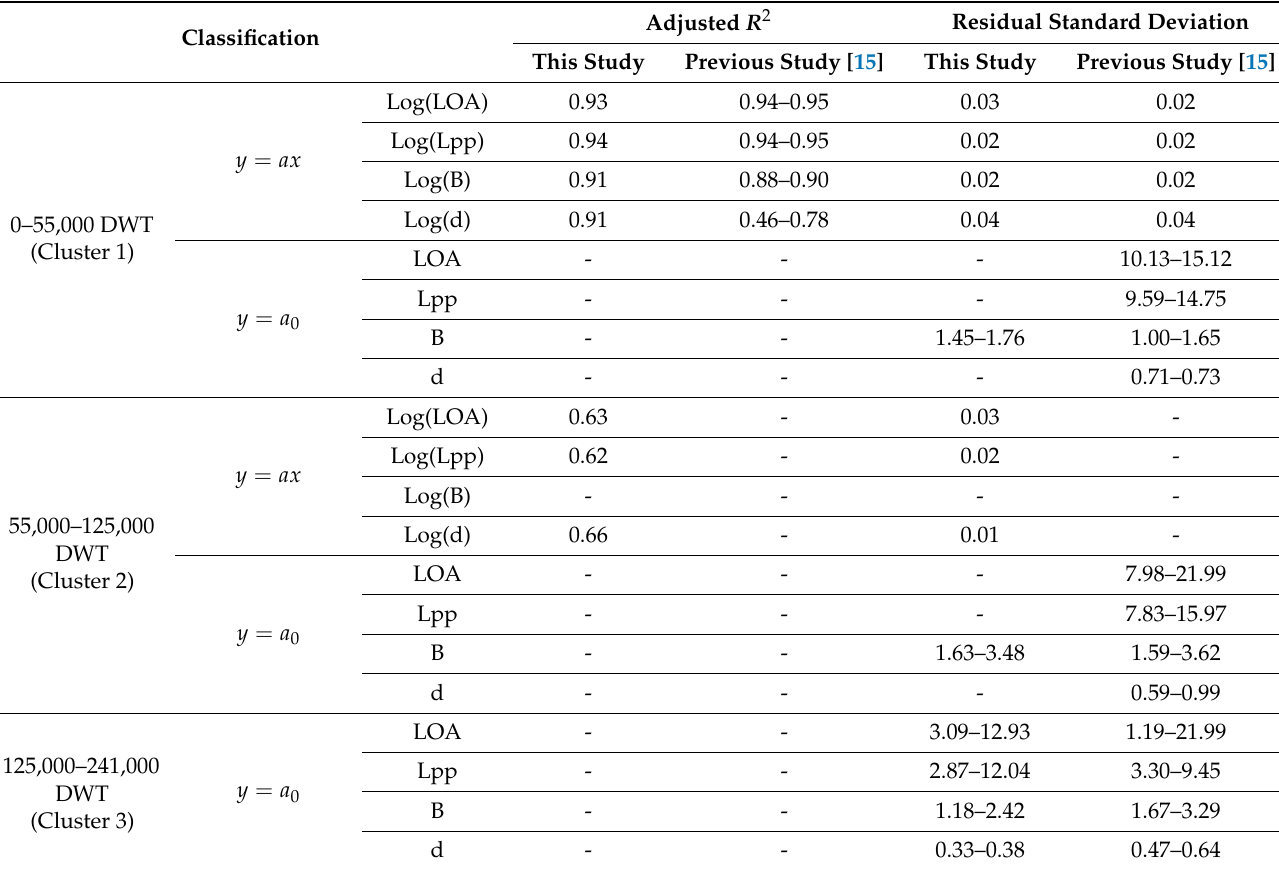
Table 7. Comparison of accuracy of results with previous